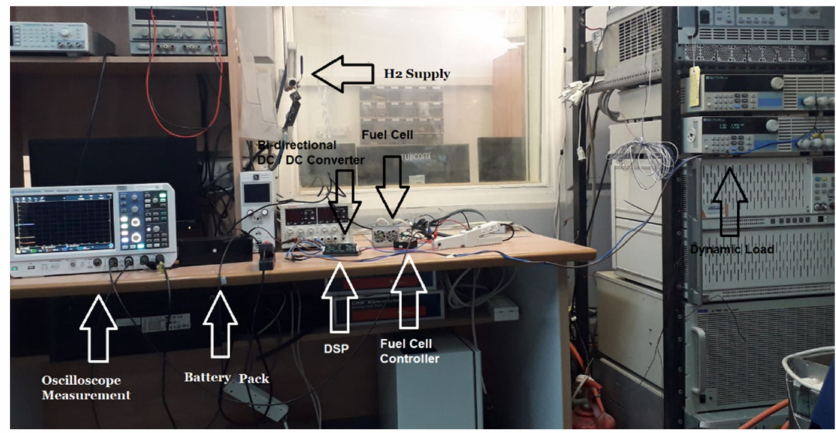
Figure 15. System